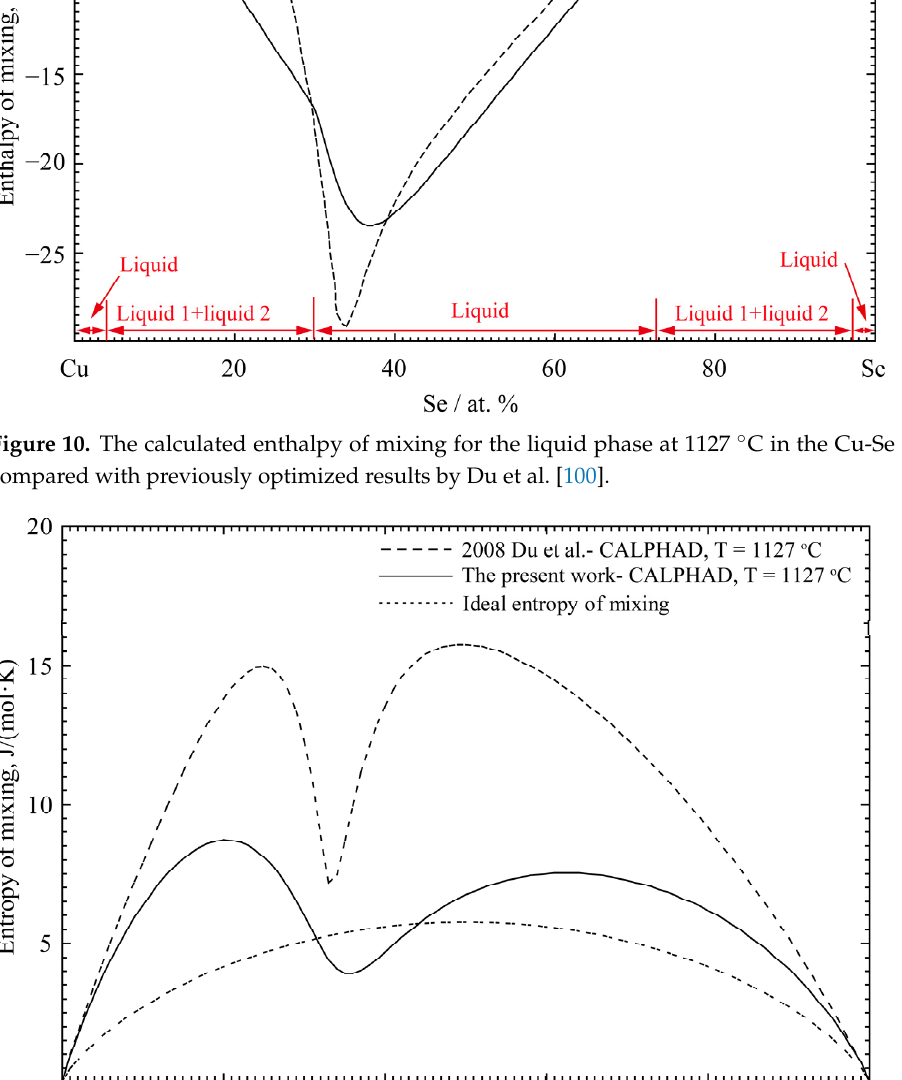
Figure 11. The calculated entropy of mixing for the liquid phase at 1127 °C in the Cu-Se system compared with the previously optimized results by Du et al. [100].